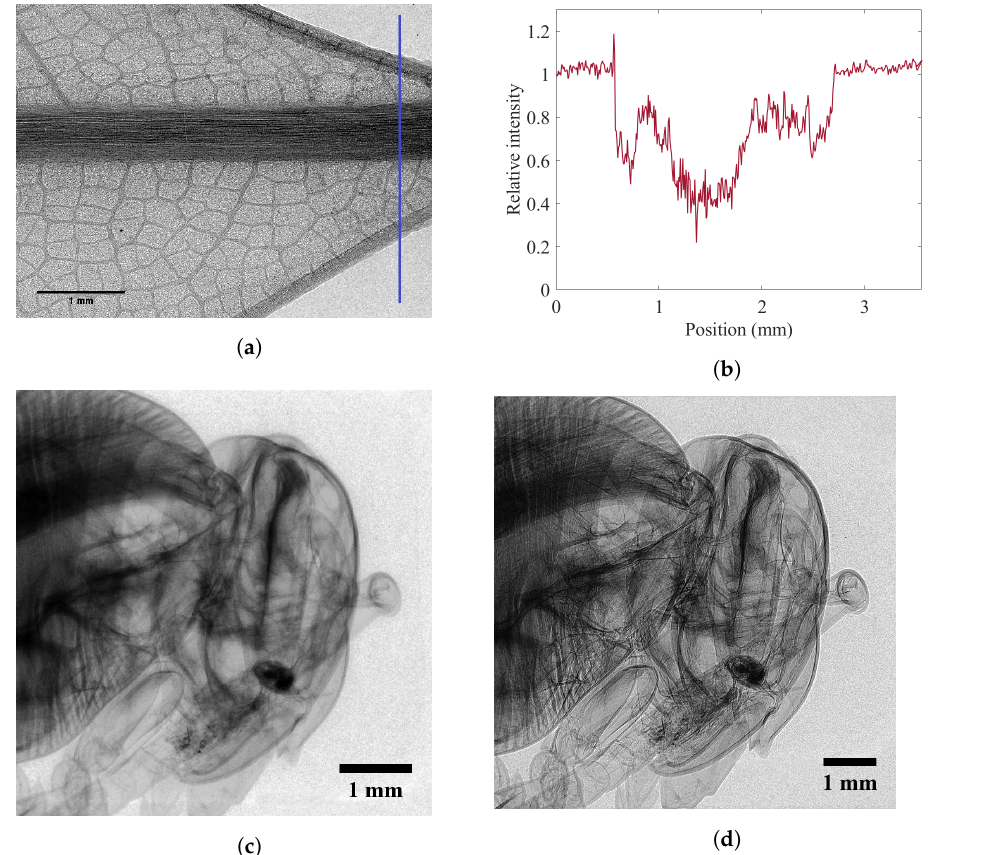
Figure 16. ( a ) Phase-contrast image of a dried bay leaf using a prototype version of the BrillianSe™ X- ray detector and a microfocus source at 60 kV p , z so = 18 cm, and z od = 8 cm; ( b ) profile of relative intensity along the vertical cross-section (blue line); ( c ) X-ray attenuation image of a bee head imaged at 60 kV p , z so = 18 cm, and z od = 1 cm; ( d ) X-ray phase-contrast image of the same bee head imaged at 60 kV p , z so = 18 cm, and z od = 8